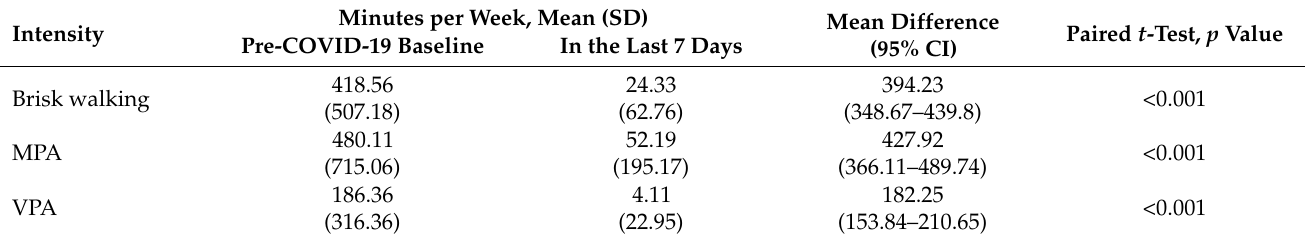
Figure 1. The number of days participants required assistance with ADL (activities of daily living) in the last 7 days compared to their pre-COVID-19 baselines. Table 3. The difference between participants activity in the last 7 days compared to their pre-COVID- 19